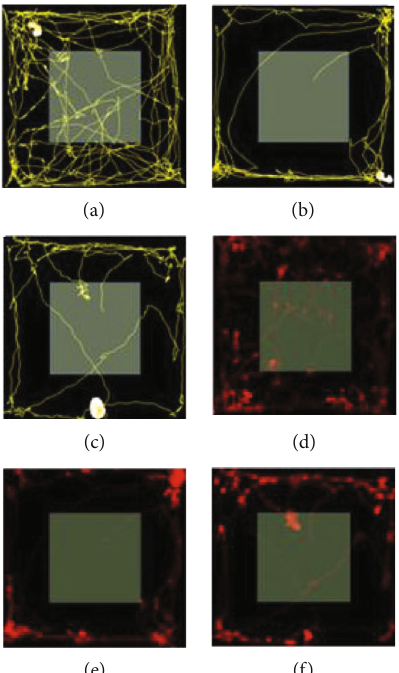
Figure 3: (a) Travel track and (d) spent time of control group; (b) travel track and (e) spent time of H. pylori+saline group; and (c) travel track and (f) spent time of H. pylori+rapa group.